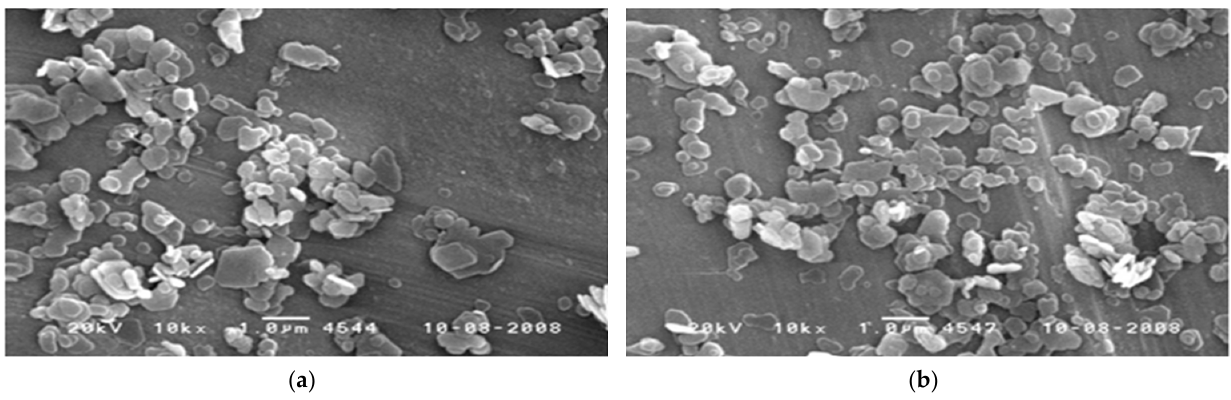
Figure 1. FT-IR spectra of Mg(OH) 2 and Mg(OH) 2 with silane.